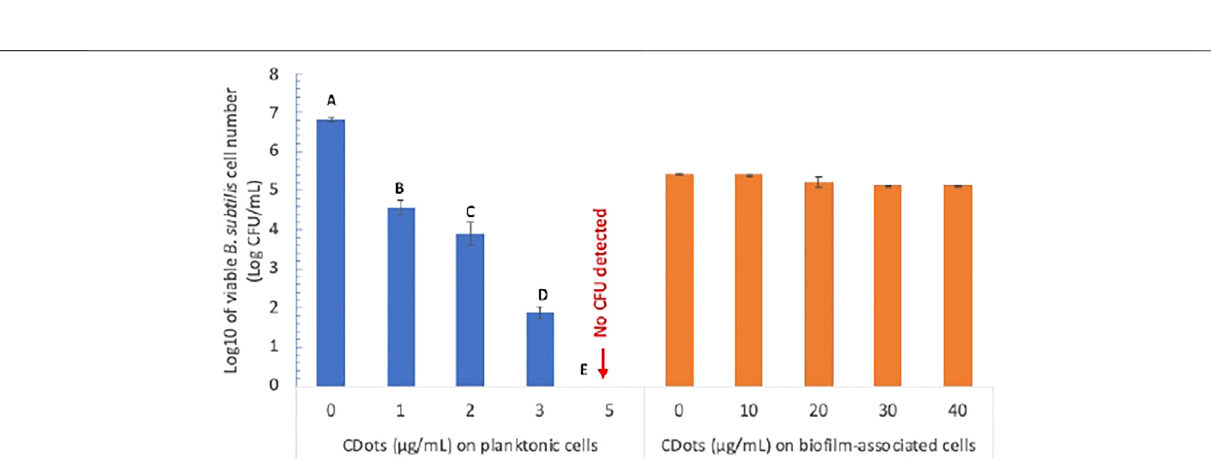
FIGURE 3 | Inhibitory effect (in percentage) of CDots and their adding time on B. subtilis bio fi lm formation. Data is presented as the mean values with ± SD as error bars. Different letters above the columns indicate statistically signi fi cant differences ( p < 0.05).